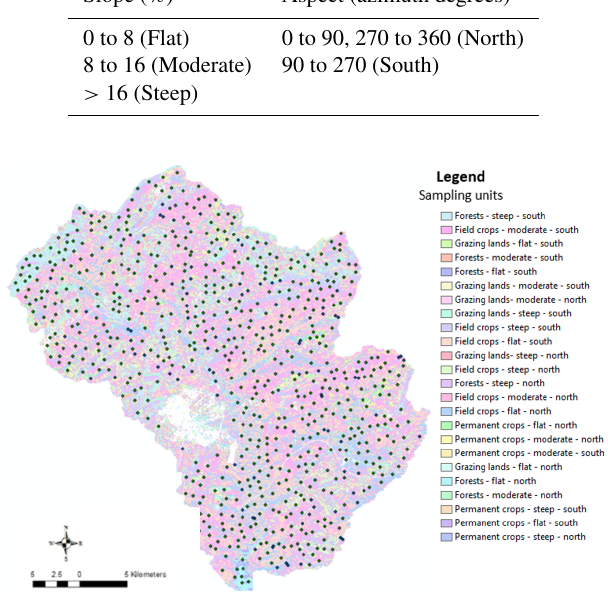
Figure 2. Location of the soil samples and the sampling design.